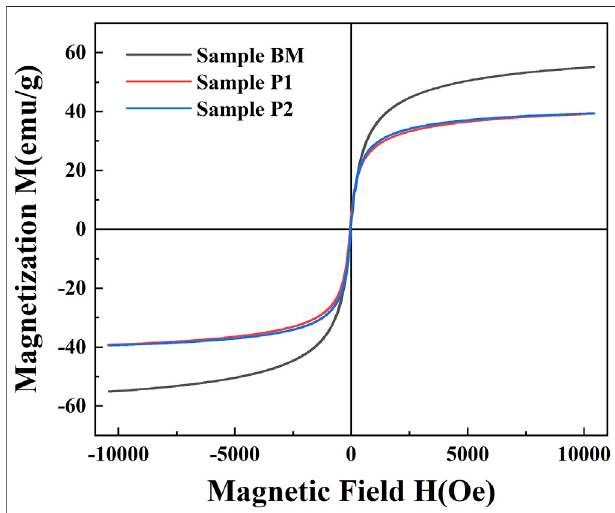
FIGURE5| Magnetization curves forbare magnetite particles (BM), OA- coated particles (sample P1), and DP-coated magnetic nanoparticles (sample